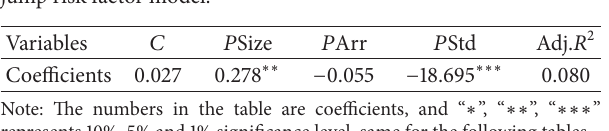
Table 4: Forecasting one-month-ahead index returns using realized jump risk factor model.